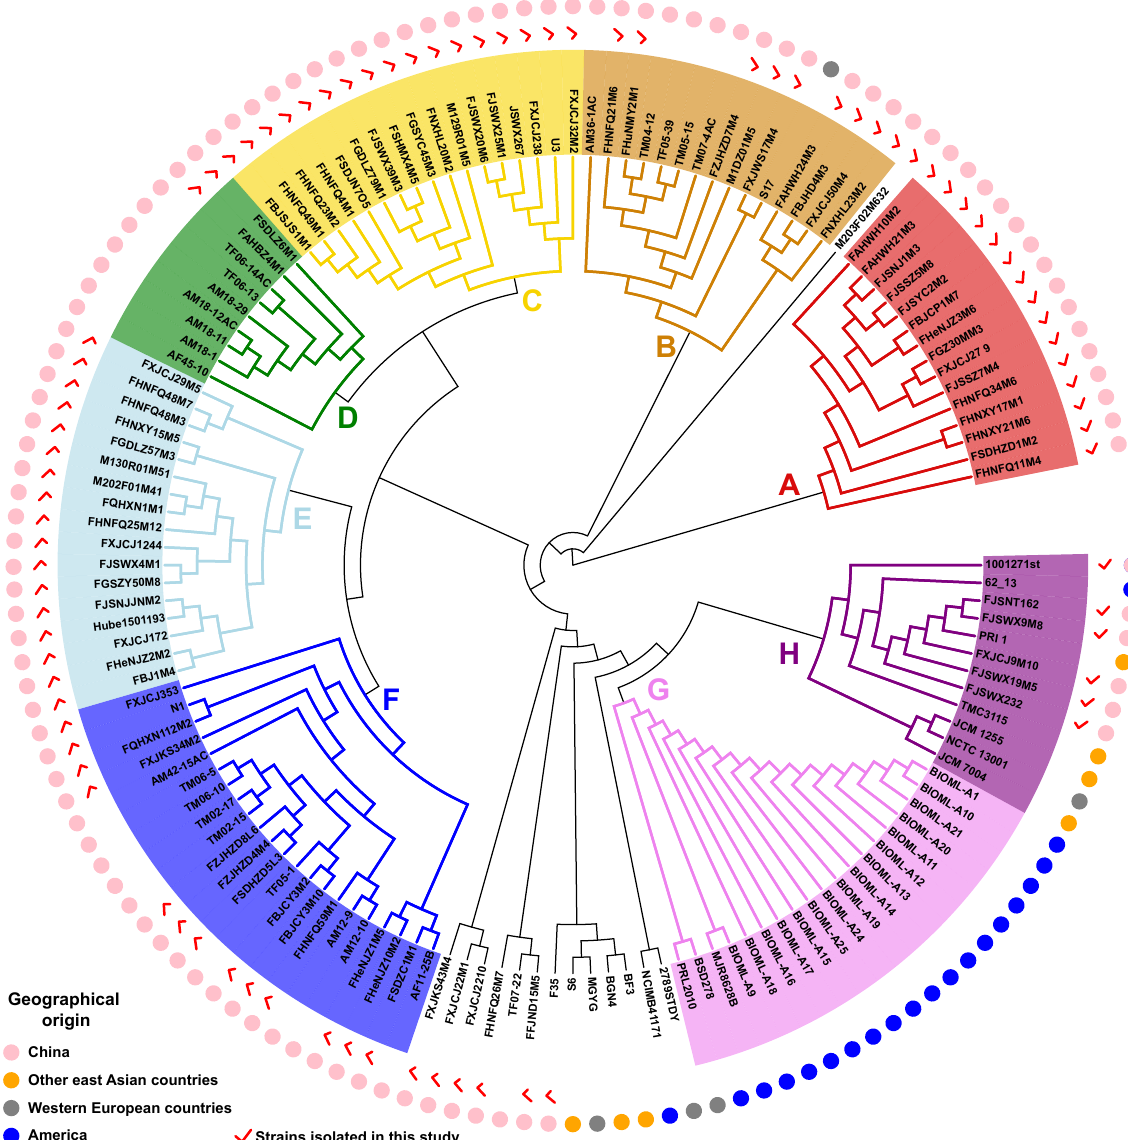
Figure 3. The phylogenetic tree of 140 B. bifidum genomes based on orthologous